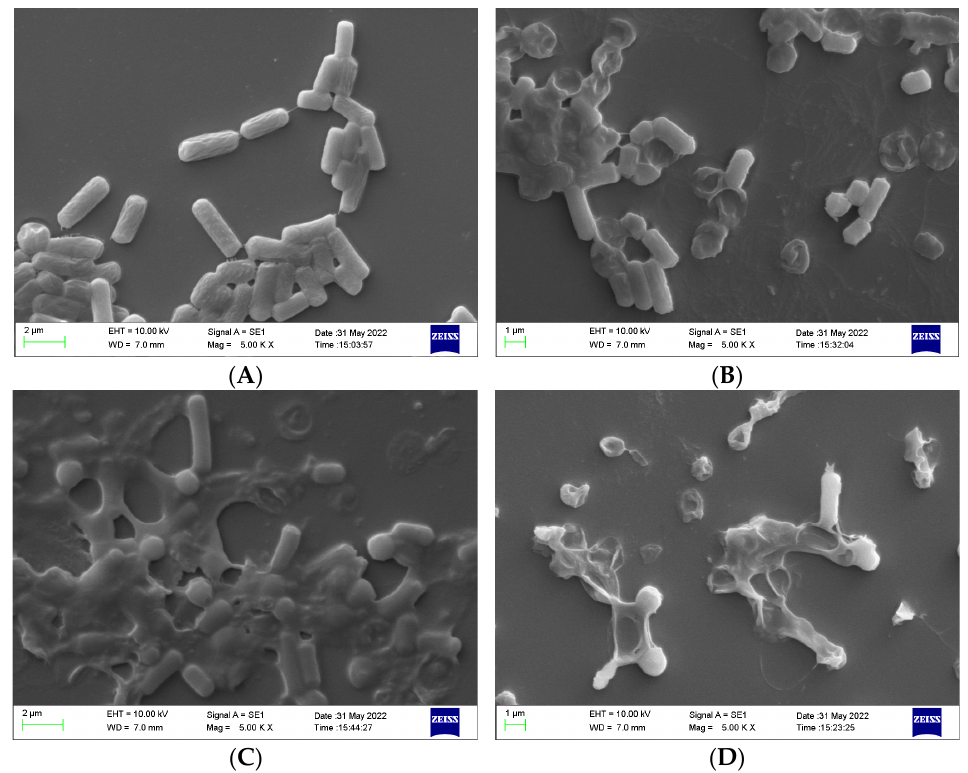
Figure 2. Microscopic images of C. perfringens cultures treated with LysCP28 (10 μ g/mL) at 37 °C.